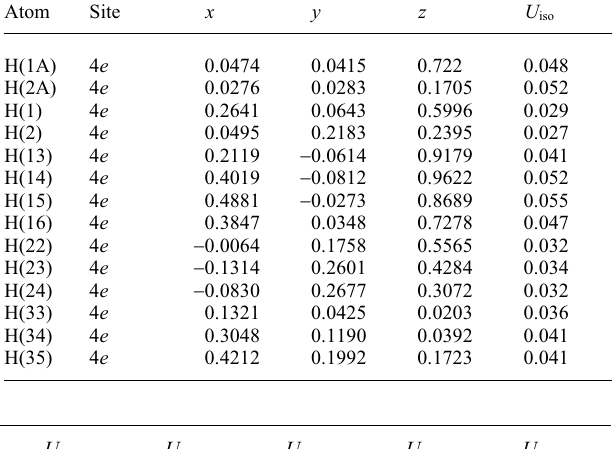
Table 3. Atomic coordinates and displacement parameters (in Å 2 )